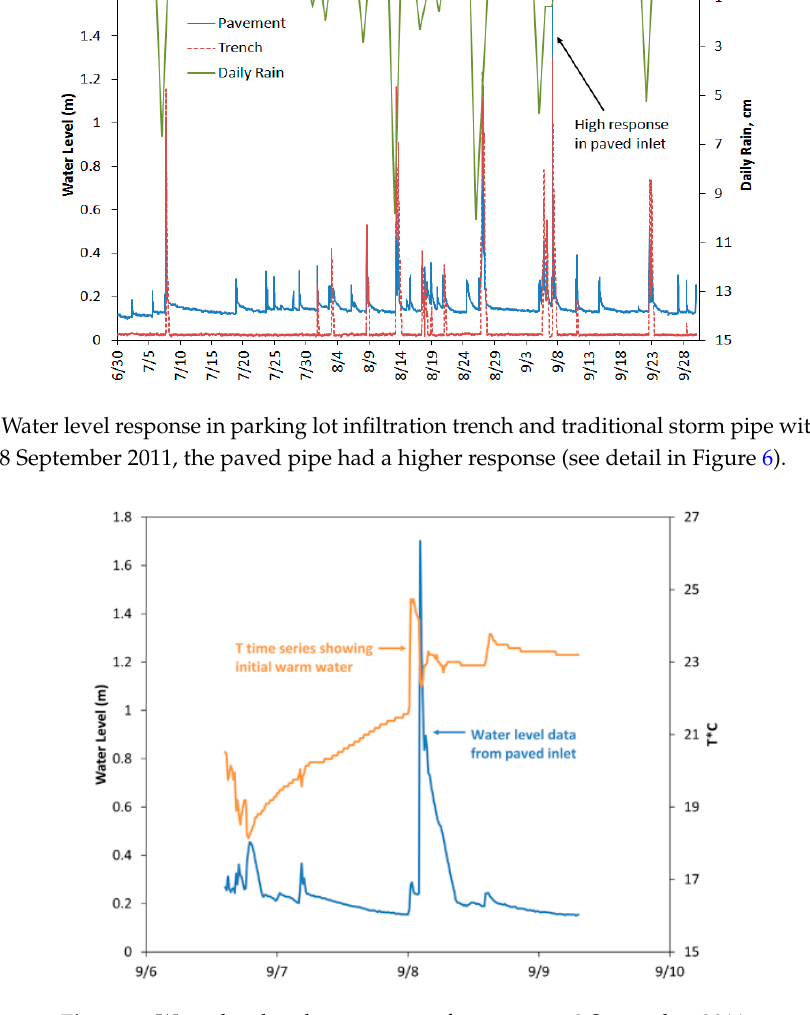
Figure 6. Water level and temperature for storm on 8 September 2011.